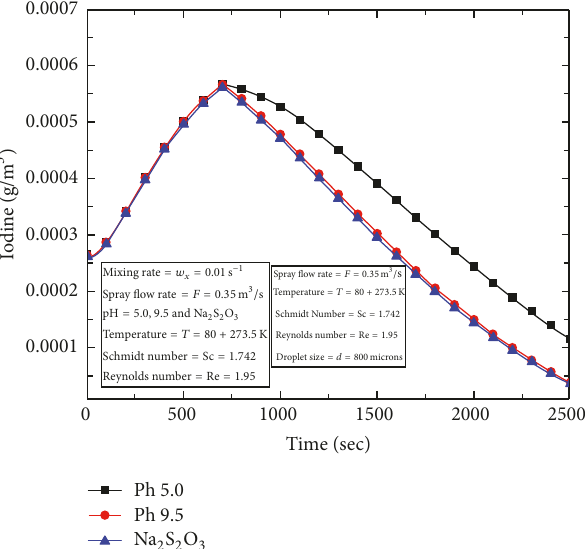
Figure 13: Response of radioactive iodine for spray pH value during in-vessel release phase with mixing rate 𝑤 푥 = 0.01s −1 .